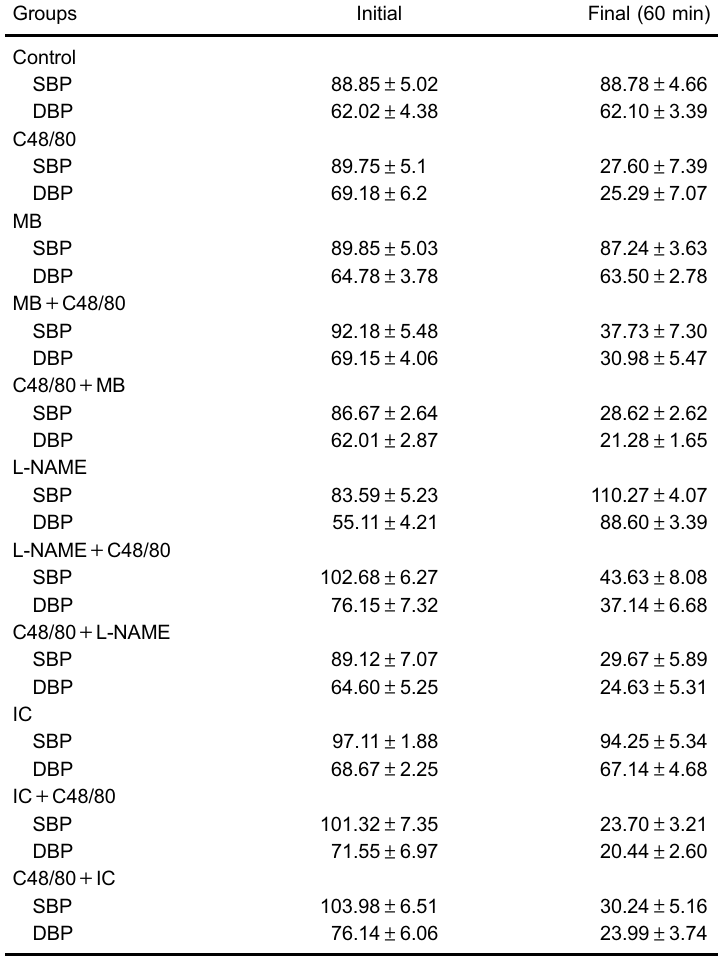
Figure 1. A , Systolic blood pressure (SBP), B , fi nal systolic blood pressure (SBP f ), and C , survival measurements of the control group and the group that received only C48/80. Data are reported as mean ± SE. *P o 0.001 C48/80 compared to control ( A : two-way repeated-measures ANOVA and Bonferroni post -test; B : one-way ANOVA and Bonferroni post -test and C : Kaplan-Meier; n=6). S: saline. Table 1. Initial and fi nal systolic (SBP) and diastolic (DBP) blood pressures of the groups